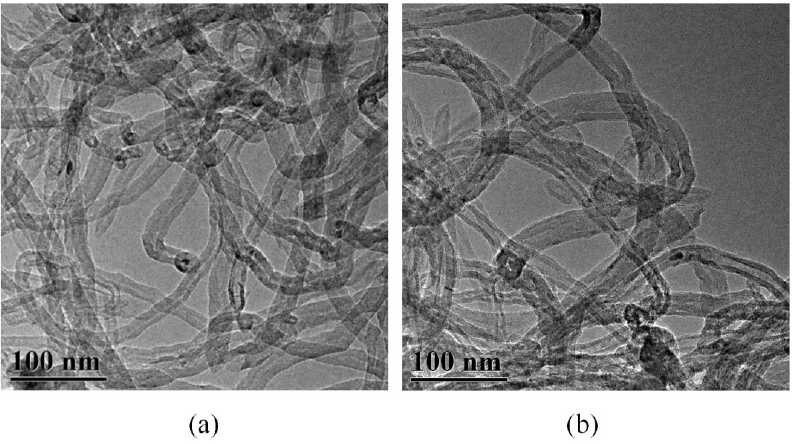
Figure 4. TEM images of CNTs ( a ) and CNTs ‐ PA ( b ).